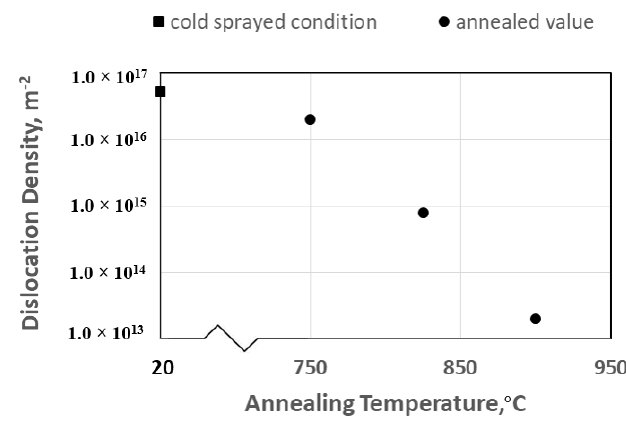
Figure 7. Copper dislocation density as a function of strain.